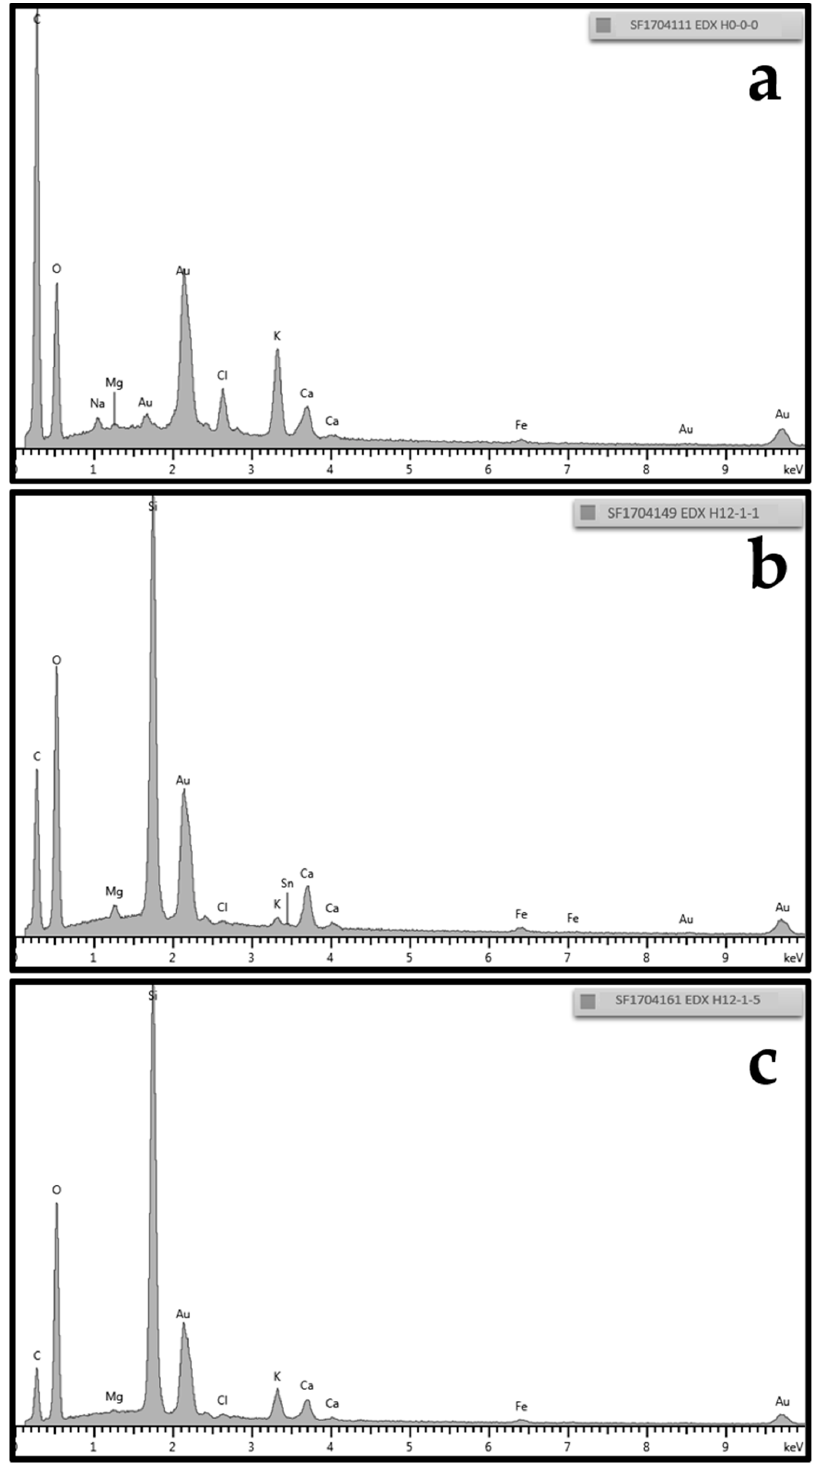
Figure 4. EDX spectra of H0-0-0, H12-1-1, and H12-1-5: ( a ) sample H0-0-0; ( b ) H12-1-1, coated once with 120 nm silica particles; and ( c ) H12-1-5, coated five times. The peaks for Au are due to the gold coating applied for SEM imaging. Courtesy of TWI Ltd.